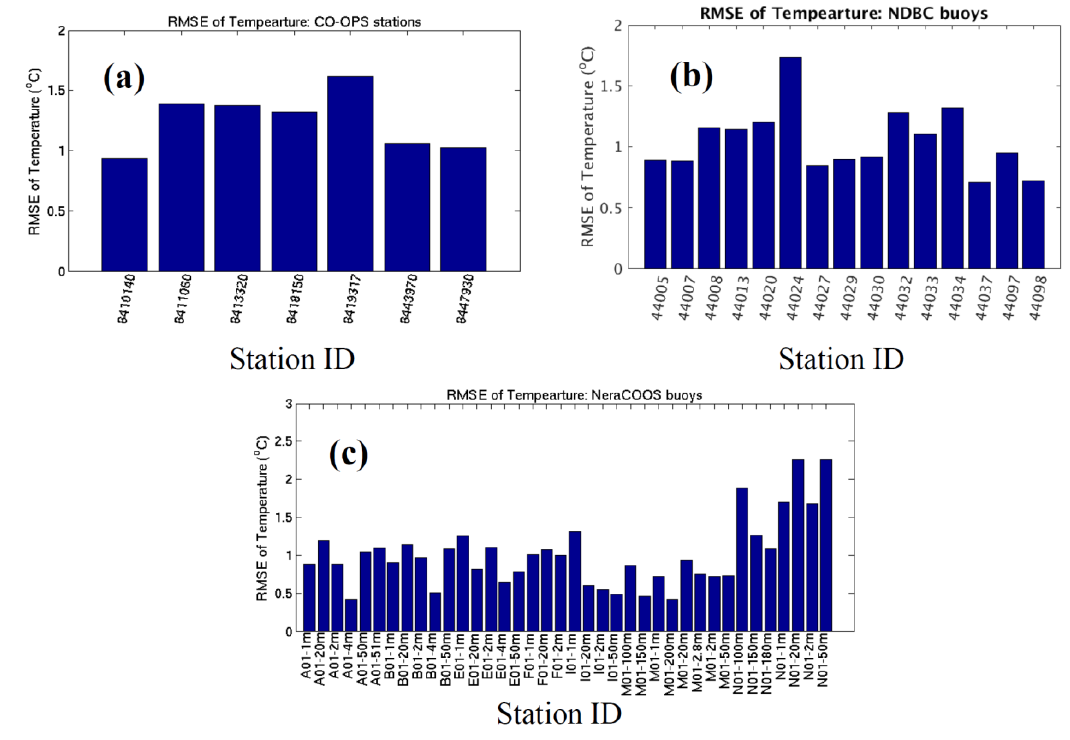
Figure 11. The RMSE of the modeled water temperature compared with three sets of observed data, ( a ) the CO-OPS stations; ( b ) the NDBC buoys; and ( c ) the NeraCOOS buoys.